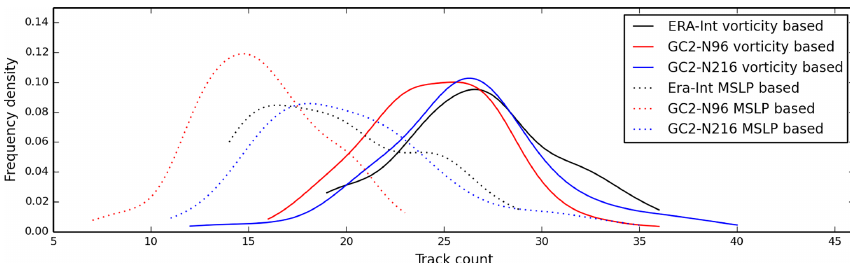
Figure 5. Frequency distributions of August cyclone track count. Use of the MSLP field in the tracking algorithm gives fewer cyclones than use of the vorticity field. The GC2-N216 climate model run is seen to give a similar number of cyclones to the ERA-Interim reanalysis (supported by a two-sample Kolmogorov–Smirnov test), while the lower-resolution GC2-N96 model run gives fewer cyclones.